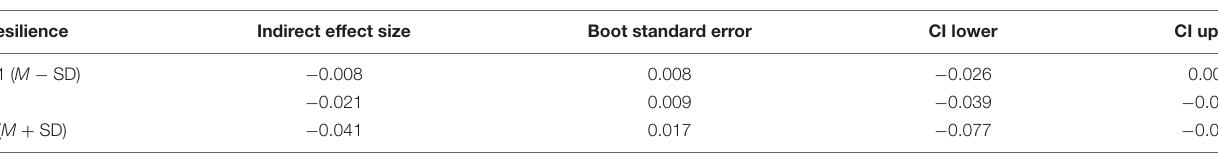
TABLE 6 | Mediating effects of resilience’s different